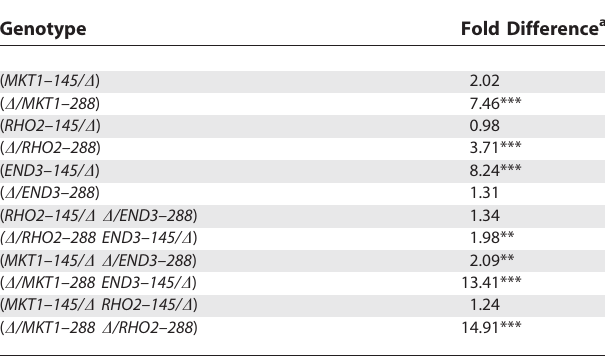
Table 2. Growth Difference at 41 8 C between a Heteroallellic Hybrid and Hybrids Heterozygous for Deletions of One or Two Htg QTGs